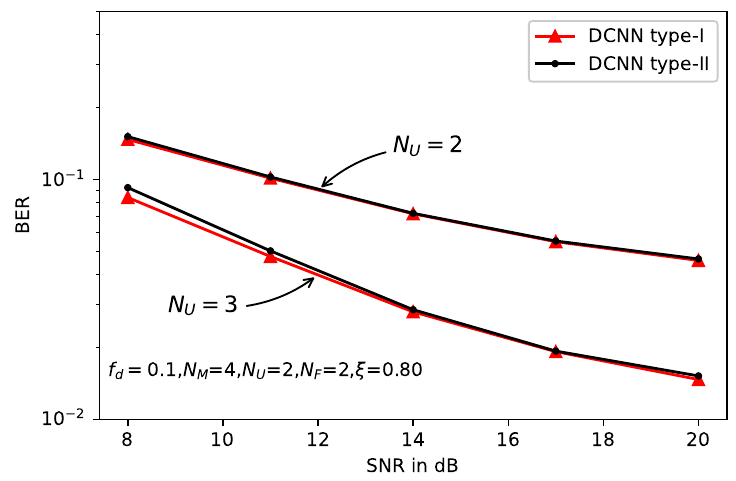
Figure 11. BER performance of deep learning-based MLD with different N U